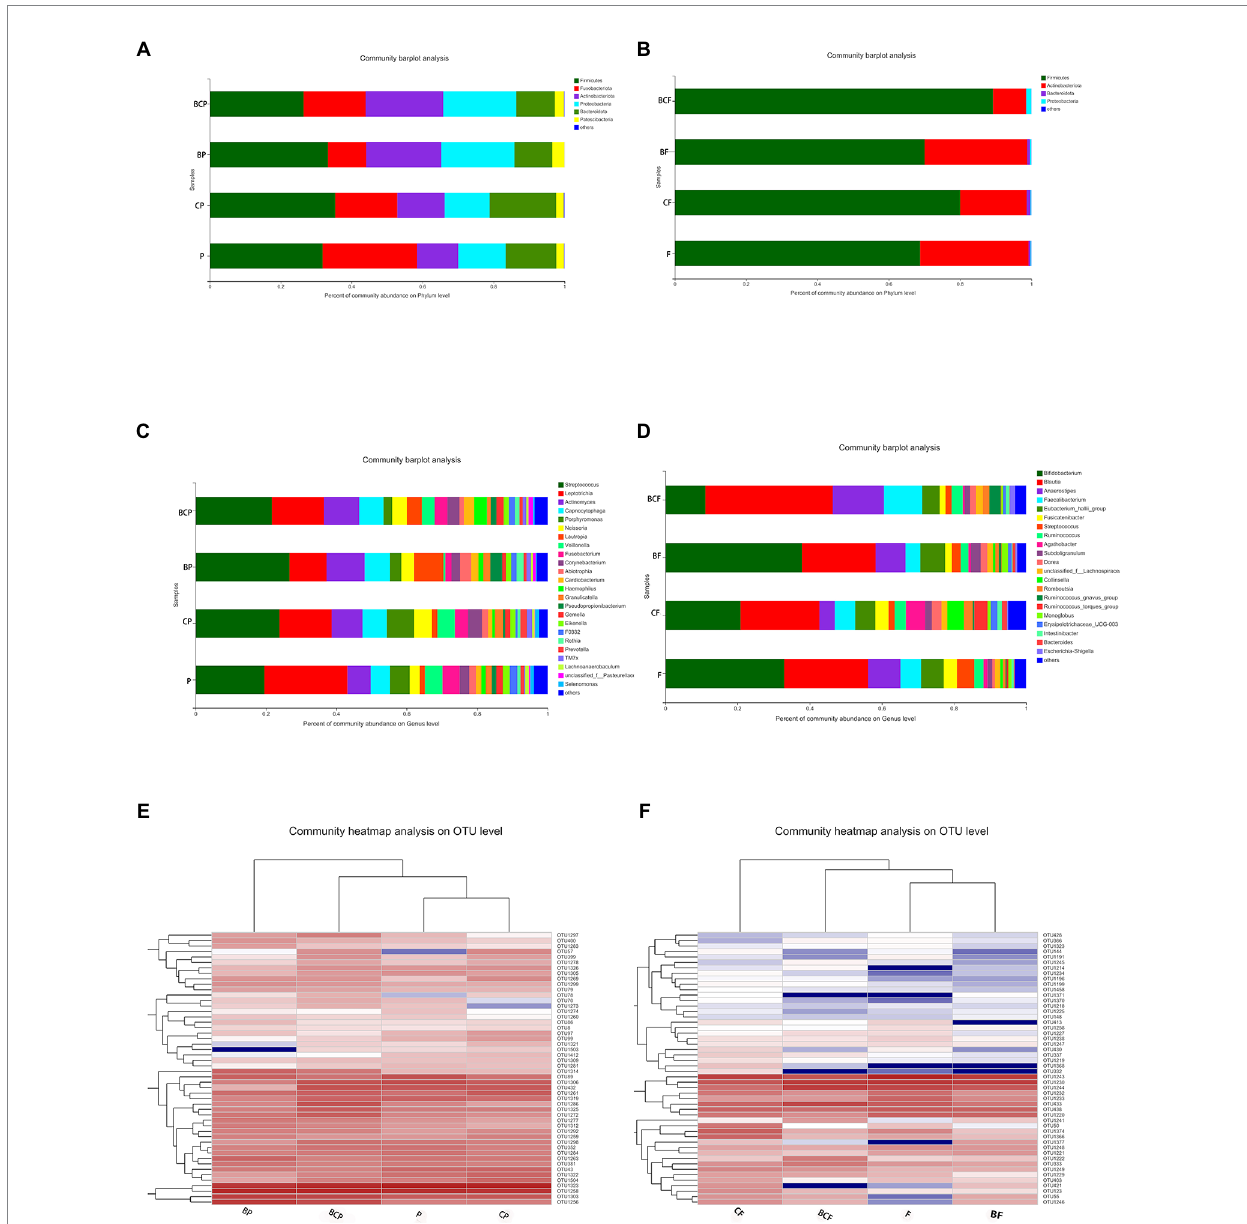
FIGURE 4 Distribution of predominant bacteria at the phylum level in (A) plaque samples and (B) fecal samples. Distribution of predominant bacteria at the genus level in (C) plaque samples and (D) fecal samples. (E) Distribution of the top-50 most abundant genera among plaque samples. Heatmaps were created using hierarchical clustering based on the (Bray–Curtis) distance. Columns represent the sample identifier, and rows represent the predominant bacterial genera. Variables of clustering are presented on the vertical axis. The relative values for bacterial genera are indicated by color intensity. (F) Bacterial distribution of the top-50 most abundant genera among fecal